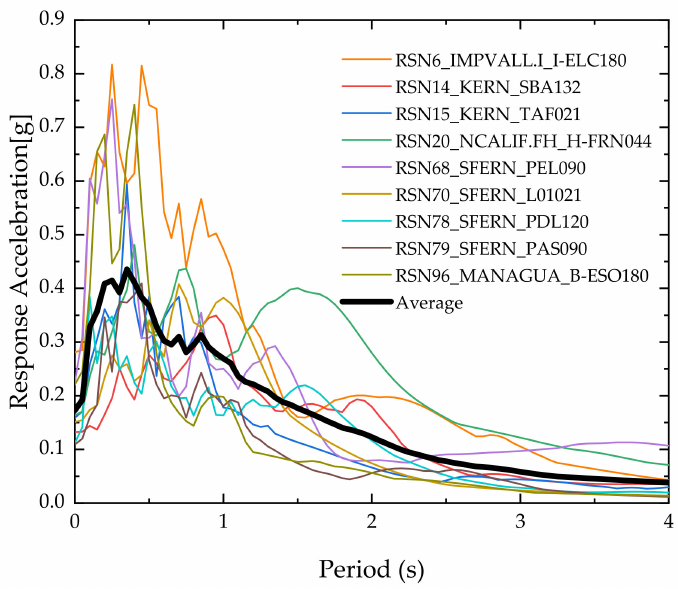
Figure 6. The response spectrum from the PEER Ground Motion Database. In each group, the ground motion with the maximum of PGA was selected and illustrated in Table